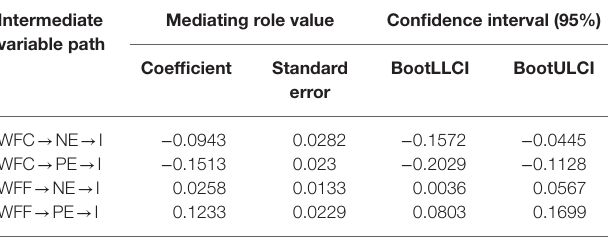
TABLE 5 | Test results of the effect of employees’ emotions (n = 405).